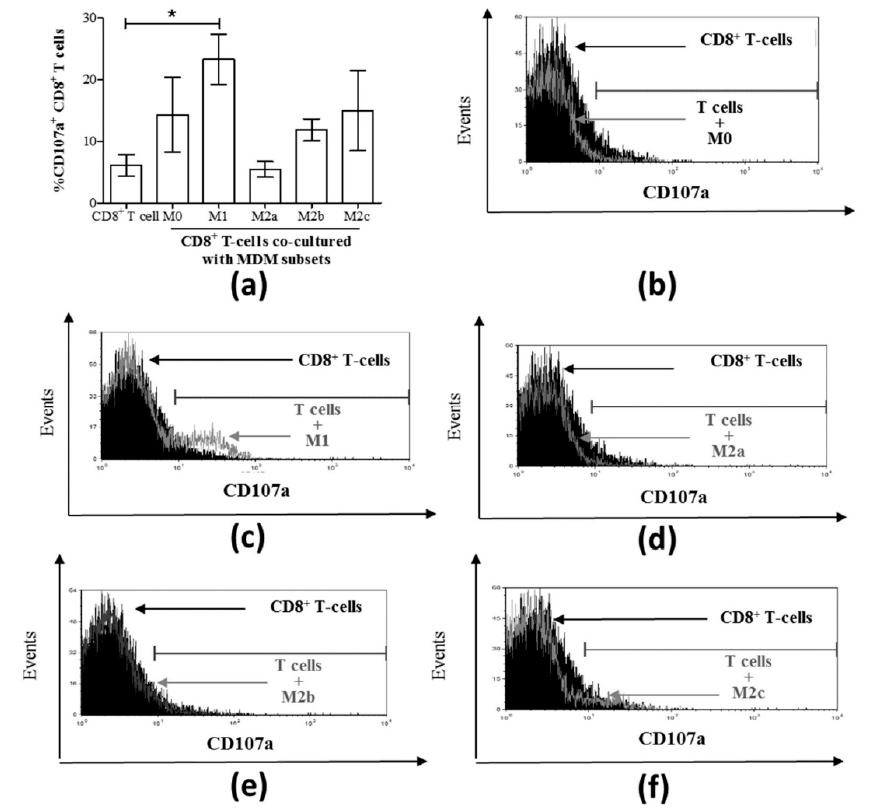
Figure 4. Only M1 macrophages cultured with CD8 + T-cells increased the proportion of CD107a + CD8 + T-cells. ( a ) MDM subsets were directly cultured with isolated autologous CD8 + T-cells for 48 h, and the expression of surface CD107a on CD8 + T-cells was assessed by flow cytometry (n = 6). Data are summarized in a graph depicting the proportion of cells expressing CD107a. Representative histograms are shown for each co-culture of T-cells with the following macrophage subsets: ( b ) M0, ( c ) M1, ( d ) M2a, ( d ) M2b, and ( f ) M2c. The histograms include traces for CD8 + T-cells cultured alone (filled black area) superimposed by co-culture traces (grey outlines). Statistical significance was determined by a Student’s t -test ( p ≤ 0.05), and significant responses are indicated with a line and an asterisk “*”.